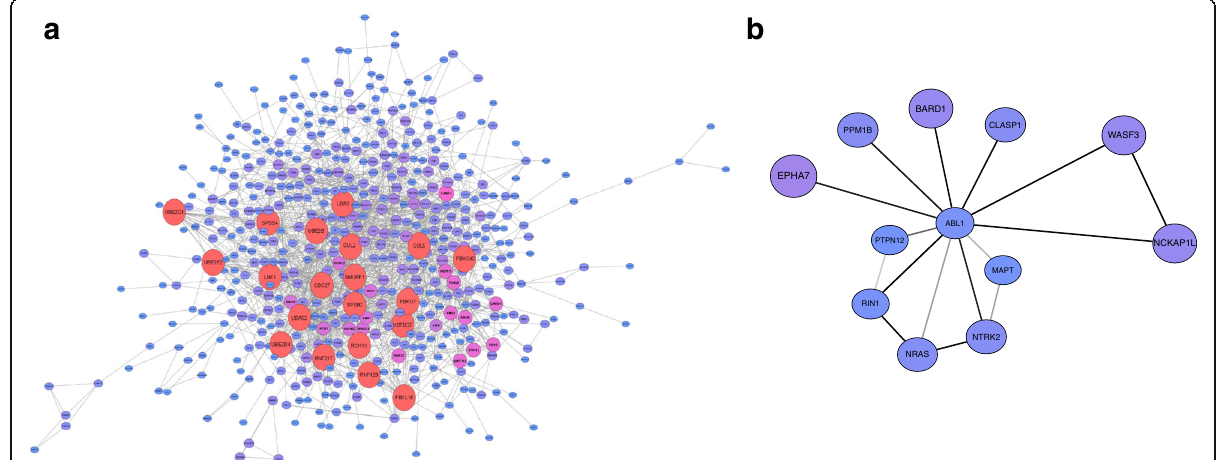
Fig. 1 Protein interaction network construction and module analysis of identified genes from hsa-miR891a-3p. a The protein interaction network of 646 identified genes; the color depth of the gene deepens with the “ degree ” of the node, and the size of the node and edges increases with the “ degree. ” b The first neighbors of selected nodes (ABL1) outgoing module in the network, including 12 nodes and 16 edges; edge line intensity increased as higher interaction. The module function is closely related to the regulation of the apoptotic process, positive regulation of cell population proliferation, and MAPK signaling